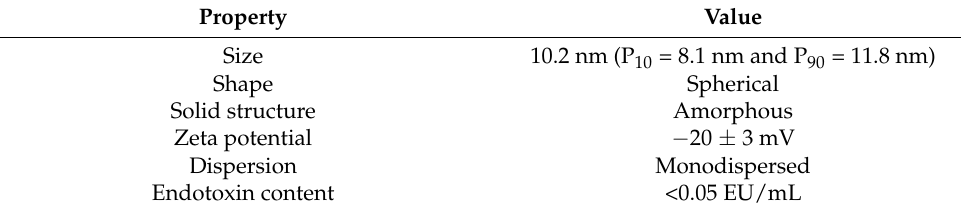
Table 1. Properties of